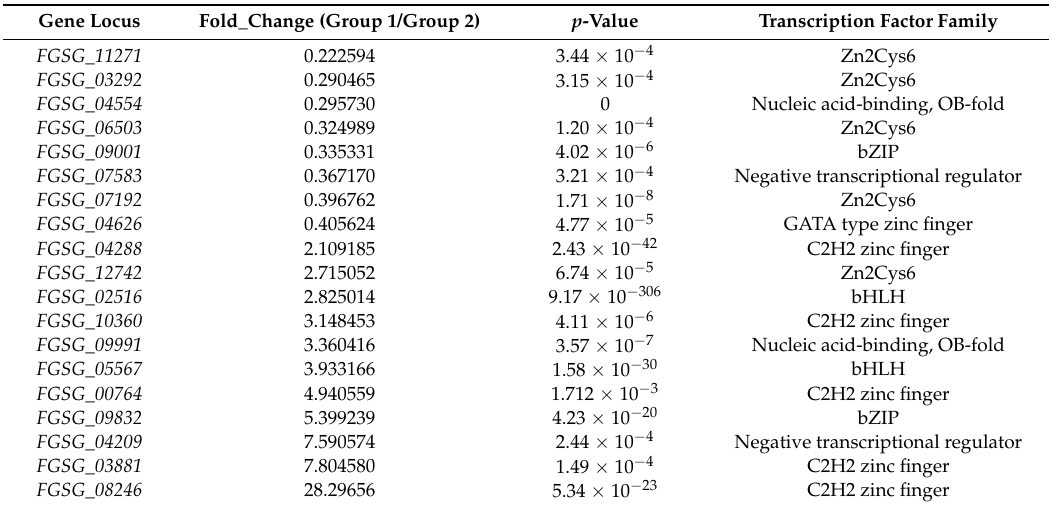
Table 3. Transcriptional factors from F. graminearum showing different expression levels in FgHV1-infected strain relative to virus-free